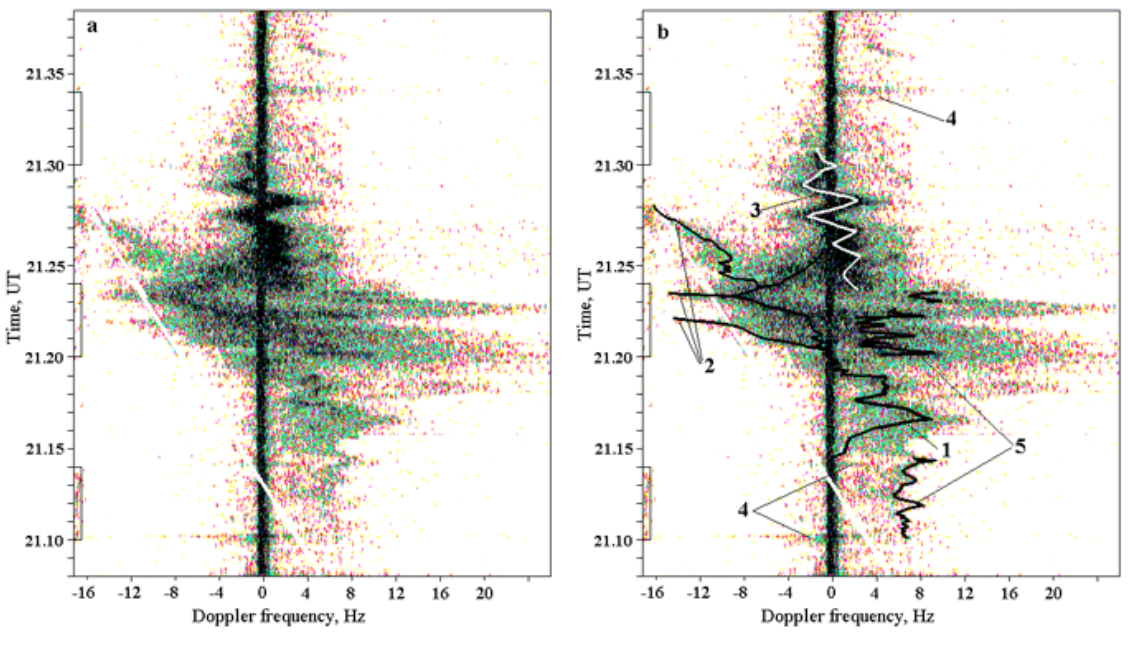
Fig. 1. Dynamic Doppler spectra (sonogram) of HF diagnostic signals on the London – Tromsø– St.Petersburg path at 9410kHz during the Tromsø HF pumping experiment on 16 February 1996. Direct signal propagating from the transmitter to the receiver along a great circle path corresponds to 0Hz Doppler frequency. The intervals when the Troms heater was turned on are marked by bars on the time axis: (a) raw dynamic Doppler spectra; (b) dynamic Doppler spectra with five types of Doppler tracks displayed on the sonogram. The following Doppler tracks can be recognized from the sonogram: (1) the long-lived track from 21:10 to 21:26UT with Doppler frequency shifts changing from positive to negative values; (2) the negative tracks of 21:20–21:22UT, 21:22–21:23UT and 21:24–21:28UT with increasing negative values of Doppler frequency shift; (3) the wave-like track with periods of about 100–120s observed from 21:23:30 to 21:30:30UT; (4) burst-like Doppler tracks closely related to the points in time at which the Tromsø HF heating facility is turned on or off; (5) wave-like tracks closely related to the heater-on periods of 21:10–21:14 and